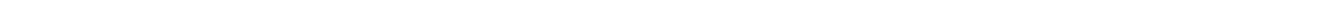
Fig. 6 Quantitative mapping of motor system connections after stroke and with CREB induction. a , c , e Each map represents all of the digitally mapped connections from all the animals in each condition ( n = 4 for each condition) from M1 anterior to the stroke site, collapsed onto a representative tangential section through the mouse cortical hemisphere. The Y and X axes show mm distance from the center of the tracer injection site. The dark blobs on the maps are the location of the primary somatosensory vibrissal fi eld (the “ barrel ” fi eld). Light blue label corresponds to the condition in the light blue labeled text at the top of each panel; red corresponds to the condition in the red label at the top of each panel; and dark blue is dense overlap. b , d , f In polar plots of connections of forelimb motor cortex projections the plot is made relative to the tracer injection in forelimb motor cortex as the origin. Each fi lled polygon (blue and red) is the 70th percentile of the distances of all BDA-labeled connections from the injection site in each segment of the graph. The lines in these plots are the median vector of that segment of the plot, multiplied by the median of the normal distribution of the number of points in a given segment of the graph. P value is Hotelling's T 2 . g Schematic summary of axonal sprouting after stroke with CREB